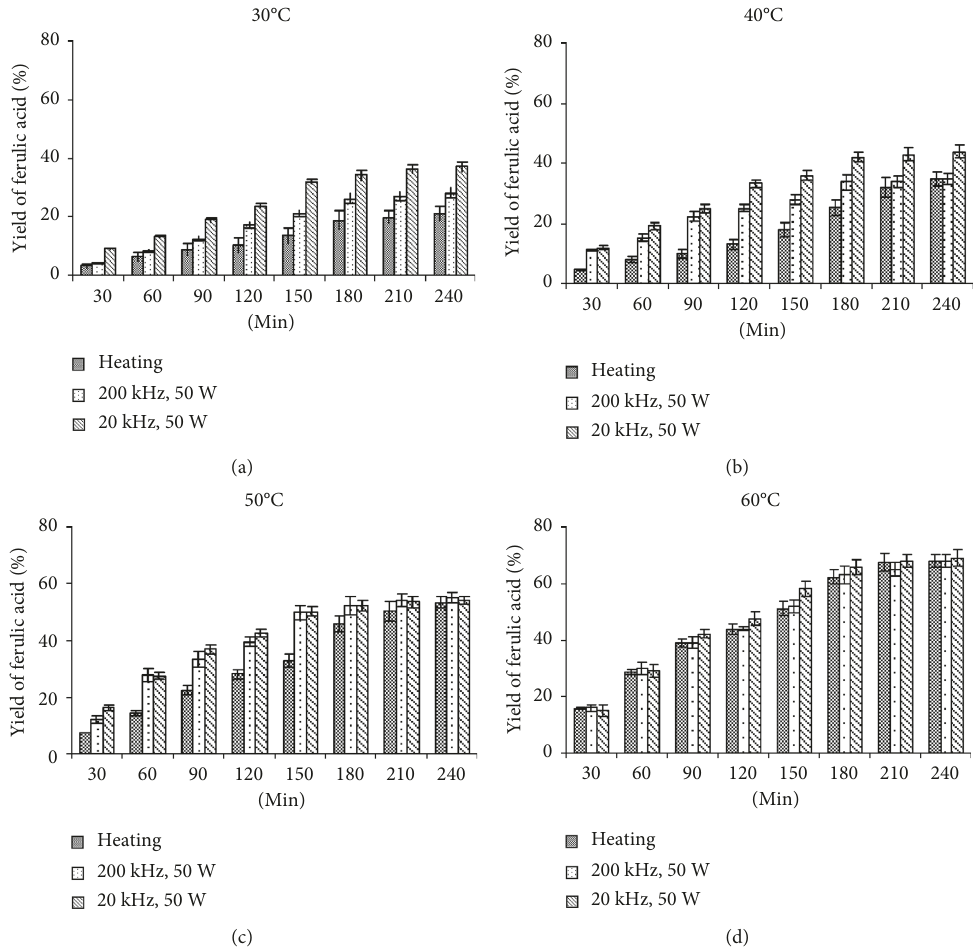
Figure 3: The yields of ferulic acid obtained by the heating method and the ultrasound-assisted method (20 and 200kHz, 50W) by varying reaction temperature from 30 to 60 ° C (A20).